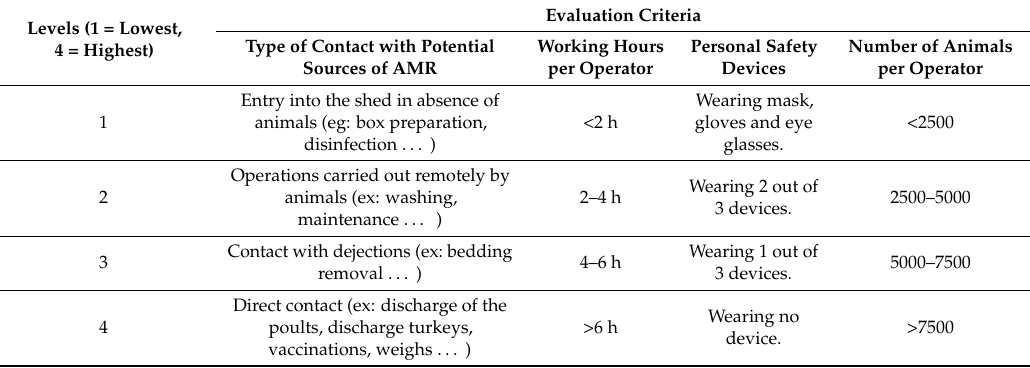
Table 7. Levels of exposure of farm workers to AMR determinants, in turkey farming, for four evaluation criteria.